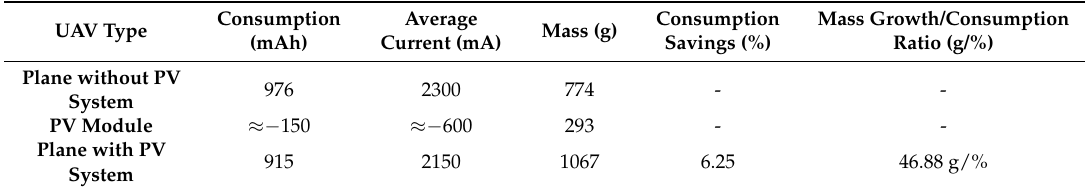
Table 3. Charge consumption during the 15 min flights, average current consumption and the mass of different model airplane parts.